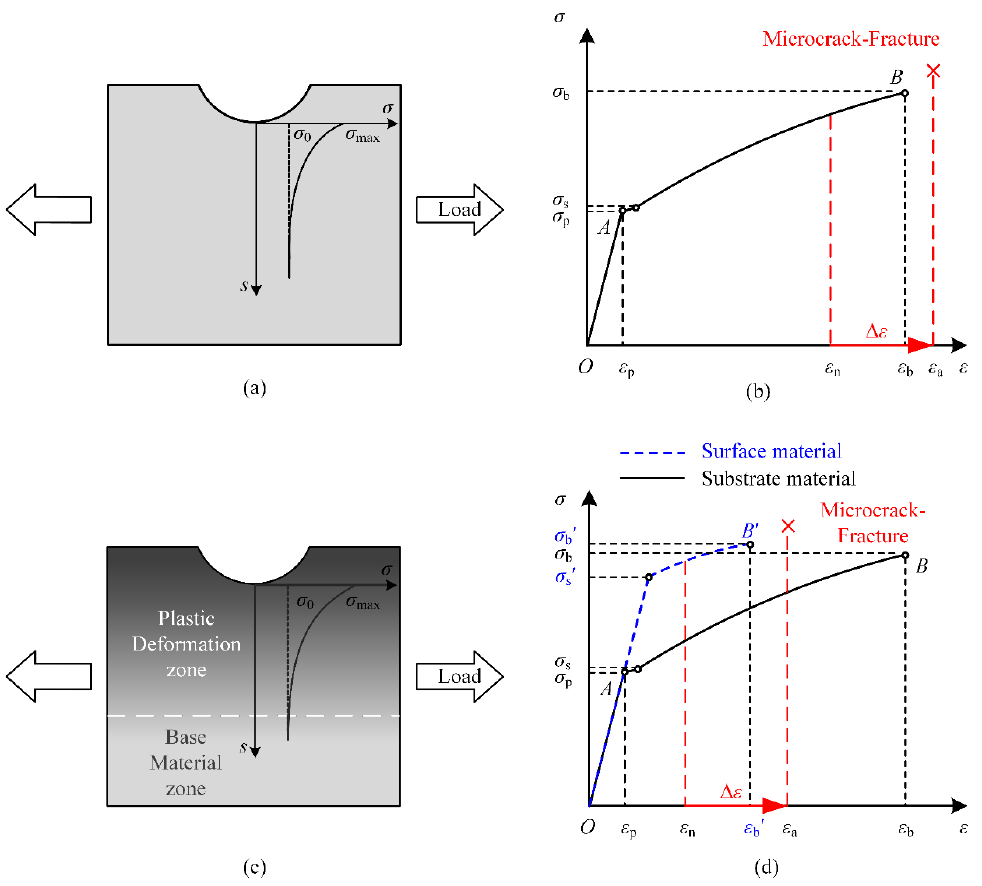
Figure 6. Schematic diagram of surface stress (strain) concentration and microcrack initiation process: ( a , b ) for as received; ( c , d ) for plastic deformation